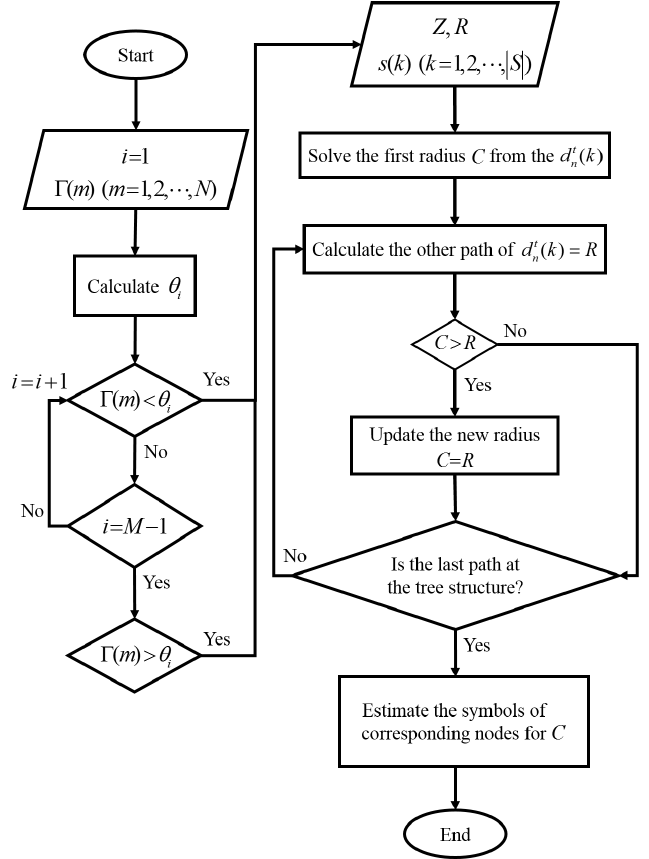
Figure 5. The flowchart for the proposed DFSD detection